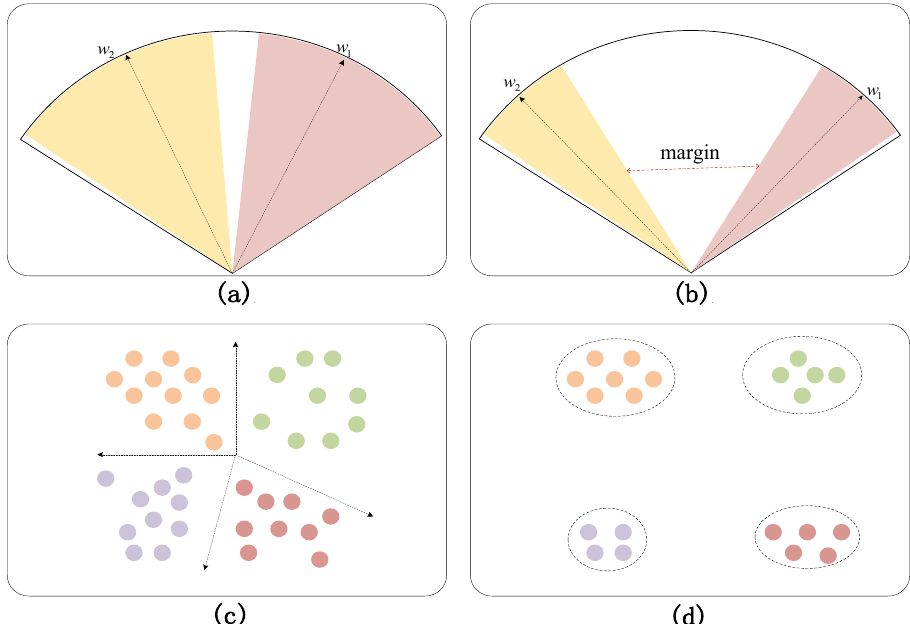
Figure 6. ( a , c ) denote representation learning using softmax as the loss function, and ( b , d ) denote representation learning using angular softmax as the loss function. The different colors shown in the four sub-figures represent different classes. ( a , b ) show the Binary Classification, and ( c , d ) show the Multi-Class Classification. As shown in the figure, angular softmax enables us to let features belonging to the same class be distributed more closely in the feature space. It makes the samples of different classes easier to be distinguished from each other, thus achieving stronger generalization performance. The learned representations are also more